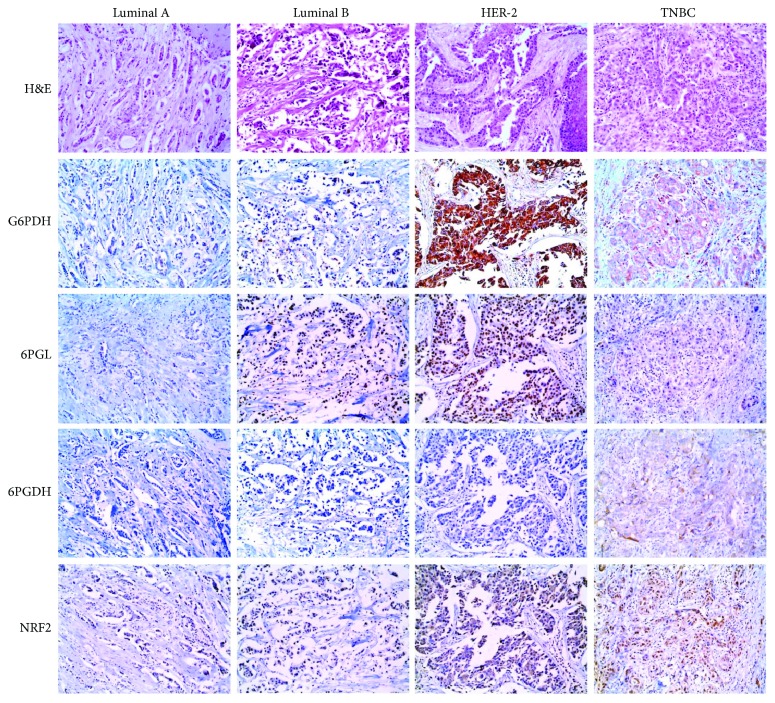
Expression of pentose phosphate pathway-related proteins in breast cancer. G6PDH and 6PGL show higher expression in HER-2 type and lower expression in luminal A type. 6PGDH expression is detected only in the TNBC subtype.